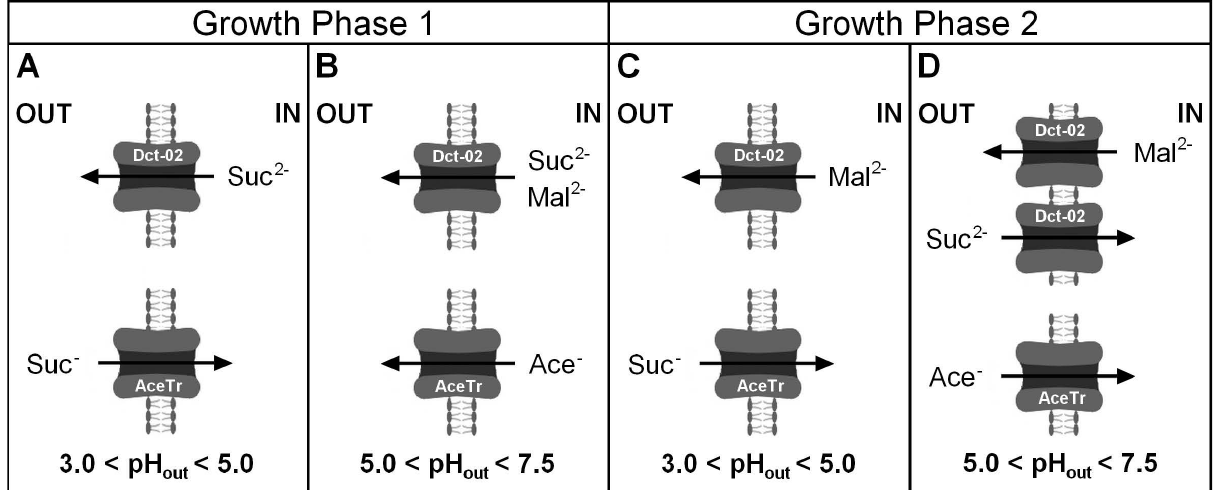
Figure 6. Schematic representation of transport reactions mediated by AceTr homologues and Dct-02 during two distinct cultivation conditions. Growth phase 1 corresponds to glycerol consumption and growth phase 2 corresponds to the utilization of other carbon sources, upon glycerol exhaustion. ( A ) During the phase of glycerol consumption in unbuffered medium, Dct-02 mediated the export, whereas AceTr homologues mediated the import of succinate anions. ( B ) During the phase of glycerol consumption in CaCO 3 -buffered medium, Dct-02 mediated the export of succinate and malate anions, whereas AceTr homologues did not mediate the import or export of succinate anions. In these conditions, Ato1 E144A, L219A and SatP L131A mediated the export of acetate anions. ( C ) After glycerol exhaustion in the unbuffered medium, Dct-02 mediated the export of malate anions. AceTr homologues mediated the import of succinate anions. ( D ) After glycerol exhaustion in a CaCO 3 - buffered medium, Dct-02 mediated the import of succinate and the export of malate anions, whereas AceTr homologues mediated the import of acetate anions. OUT: extracellular; IN: intracellular;